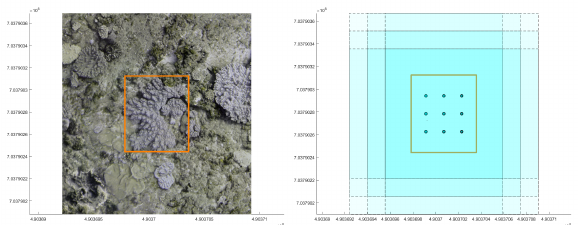
Figure 2. (Right) Bounding box of a coral in the ortho-mosaic map. (Left) Cropping Windows for the oversampling in data space; the points indicate the centers of such windows. This coral will be replicated 9 times in the final dataset.